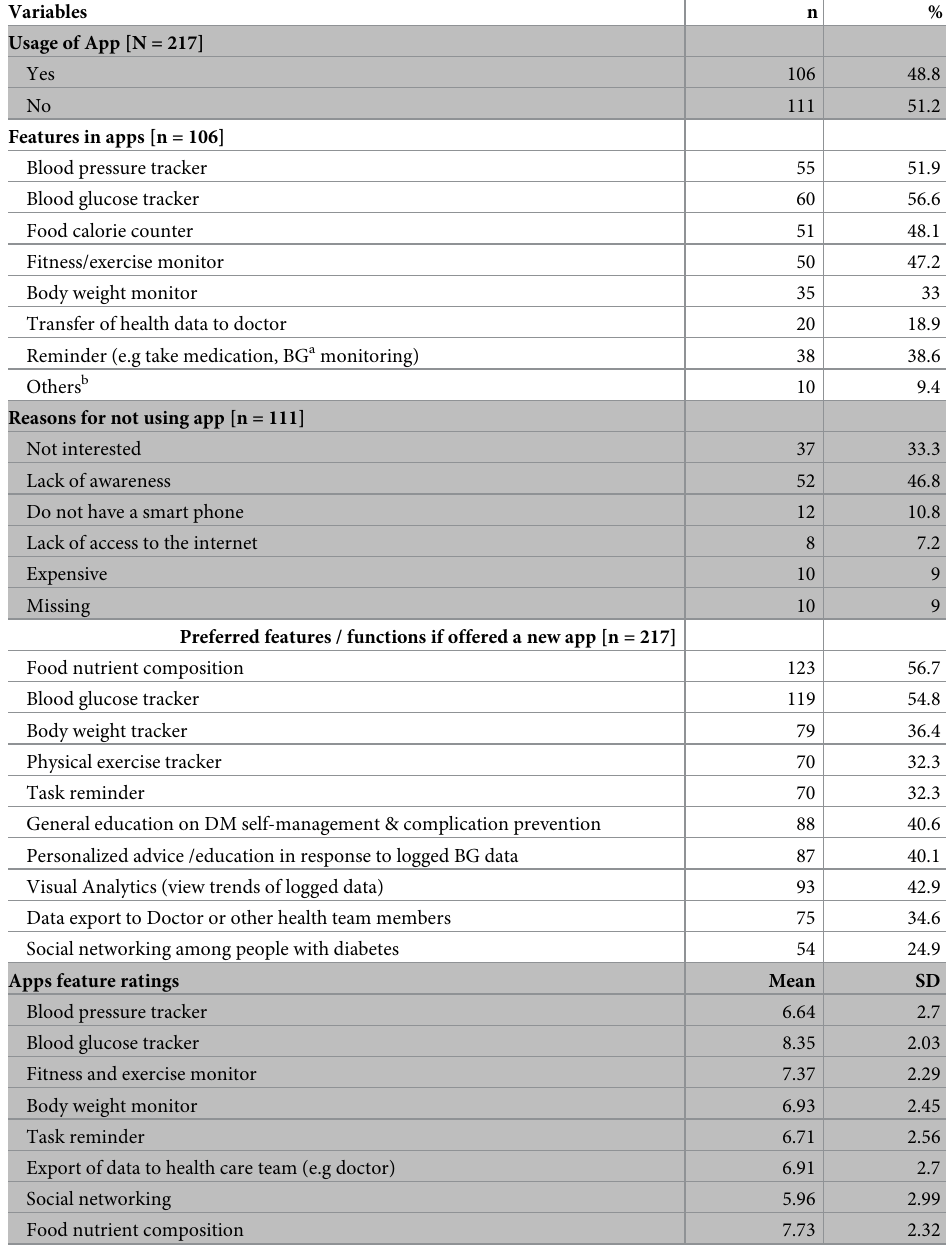
Table 2. App use, preferences and perceived usefulness of app features to support diabetes management.